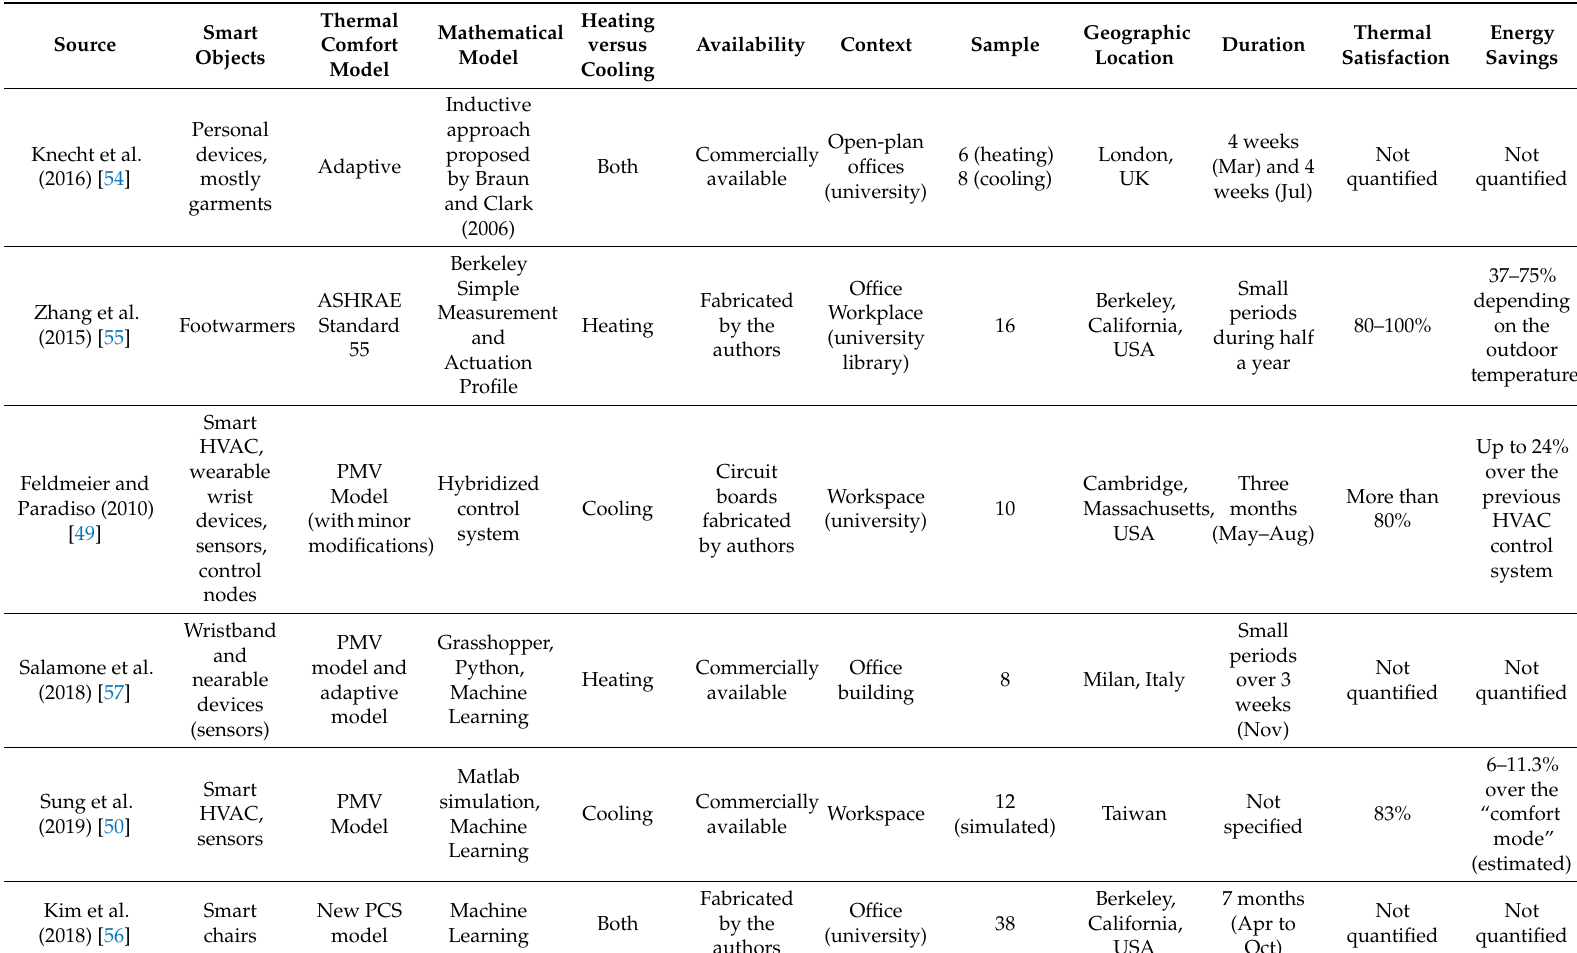
Table 1. Main contributions using Internet of Things (IoT) objects to enhance thermal